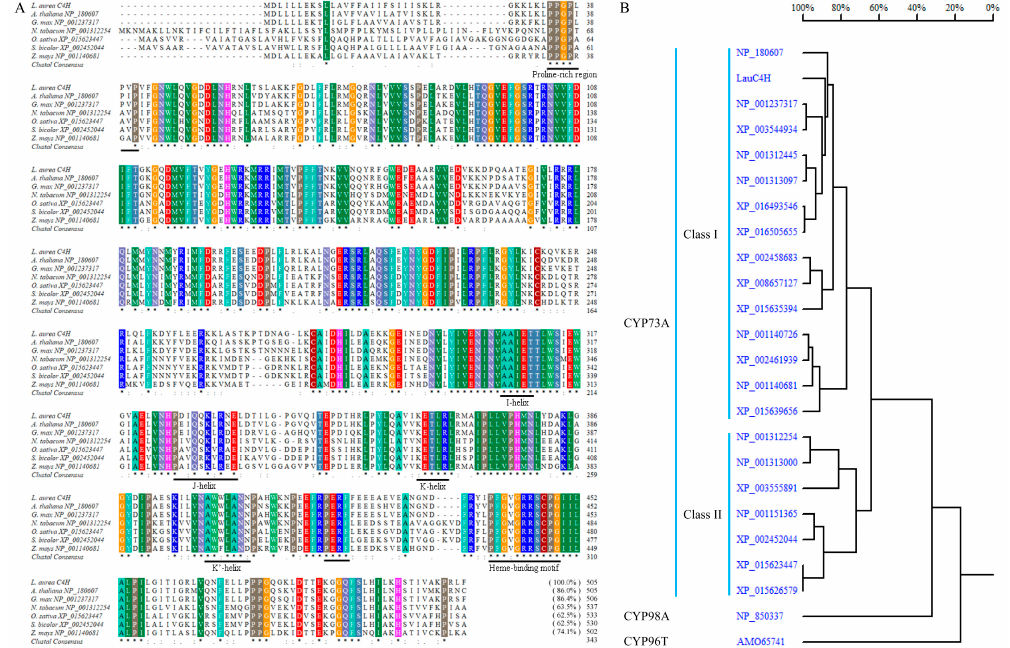
Figure 3. Sequence alignment ( A ) and homology analysis ( B ) of the full ‐ length amino acid sequence of Lau C4H with other C4Hs reported in A. thaliana (NP_180607), Glycine max